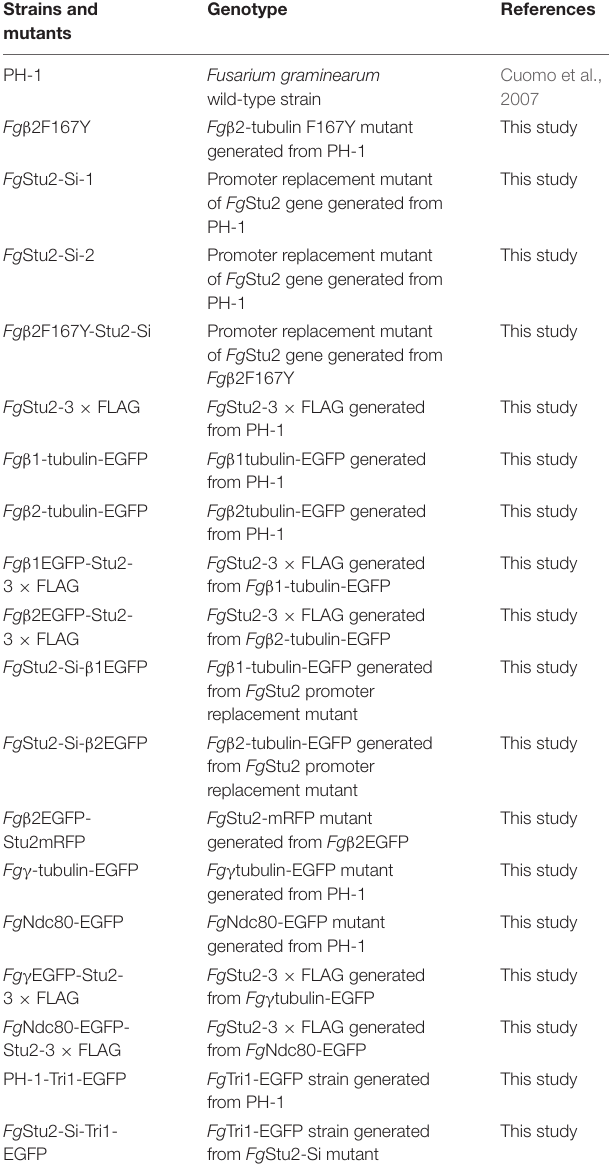
FIGURE 2 | Microtubule-associated properties of Fg Stu2p (A) Co-localization of RFP- Fg Stu2 and Fg β -tubulin-EGFP. Fresh spores (10 5 ) of all double-labeling mutants were first incubated into 20 ml of yeast extract-peptone-dextrose medium (YEPD) on an orbital shaker (175 rpm) at 25 ◦ C to germinate for 10 h and then spotted 5 µ l of culture onto the slides for micro examination. Bar = 25 µ m. (B) Co-immunoprecipitation (Co-IP) analysis of the interaction of Fg Stu2p and Fg β 1/ β 2-tubulin. The INPUT (total protein) indicates that the double labeling strains ( Fg β 1EGFP-Stu2-3 × FLAG and Fg β 2EGFP-Stu2-3 × FLAG) and single labeling strains ( Fg Stu2-3 × FLAG, Fg β 1-tubulin-EGFP, Fg β 2-tubulin-EGFP) were successfully labeled with FLAG and EGFP tags respectively; the protein samples were also detected with anti-actin antibody as a reference; the IP (Immunoprecipitation, polyclonal anti-EGFP rabbit antibody) indicates the Fg β 1-tubulin-EGFP and Fg β 2-tubulin-EGFP were precipitated by Protein-G magnetic beads which had been incubated with polyclonal anti-EGFP rabbit antibody; the IB (Immune blotting, monoclonal anti-FLAG mouse antibody) indicates that the Fg Stu2-3 × FLAG was pulled down by the Fg β 1-tubulin-EGFP or Fg β